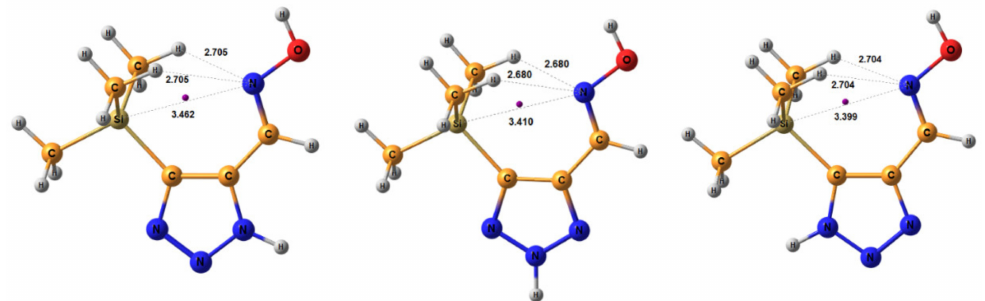
Figure 4. Equilibrium geometries of the E - syn-periplanar conformers of 4-(trimethylsilyl)-1,2,3- triazole-5-carbaldehyde oxime, optimized at the MP2/aug-cc-pVTZ level. The interatomic distances are given in Å. Violet corresponds to the bond’s critical point (3, − 1).